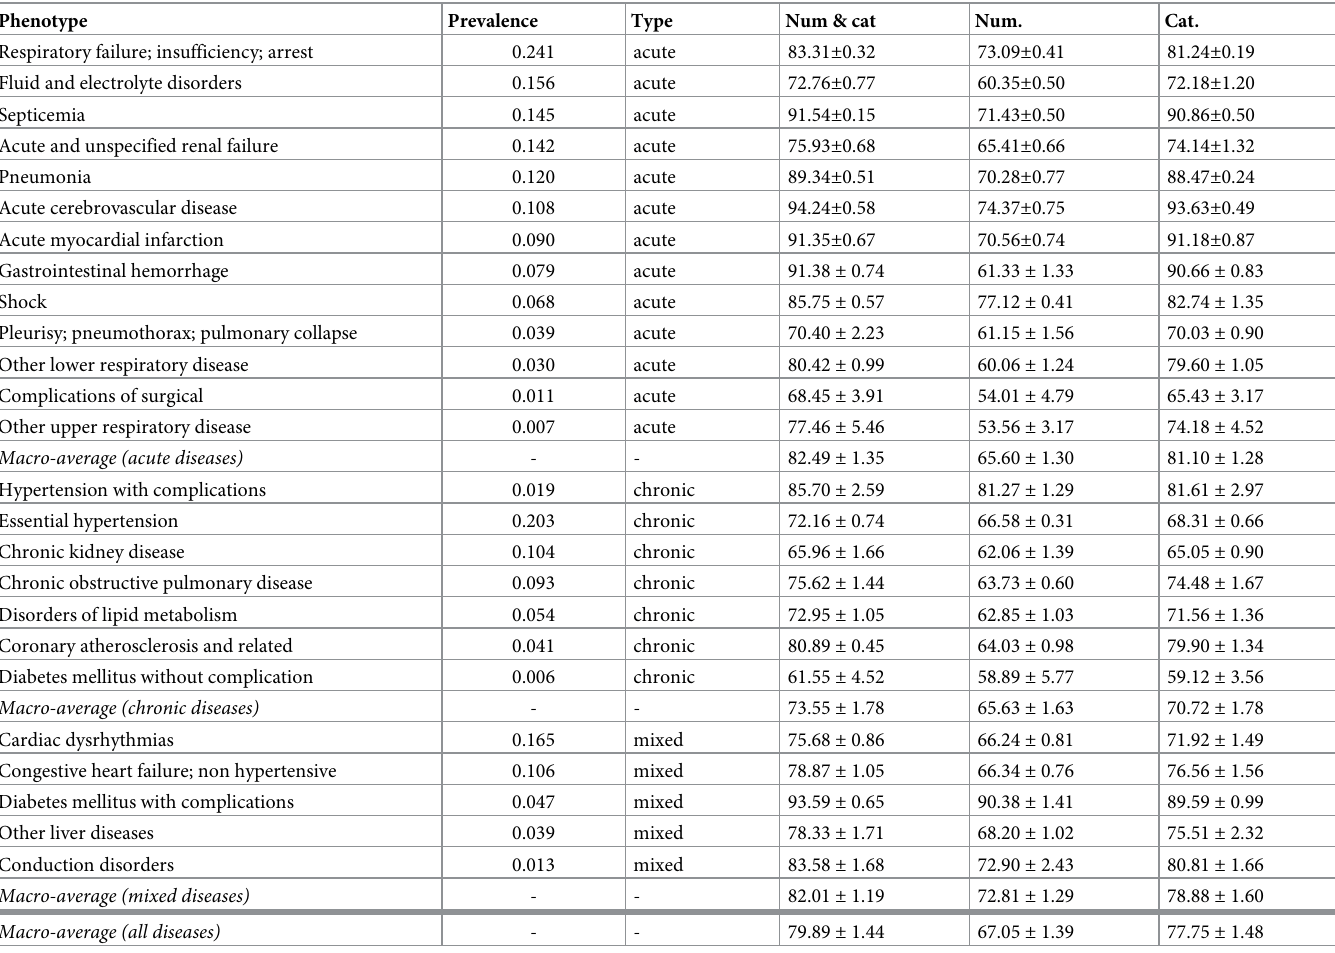
Table 7. Phenotyping task on eICU (reported scores are AUROC).